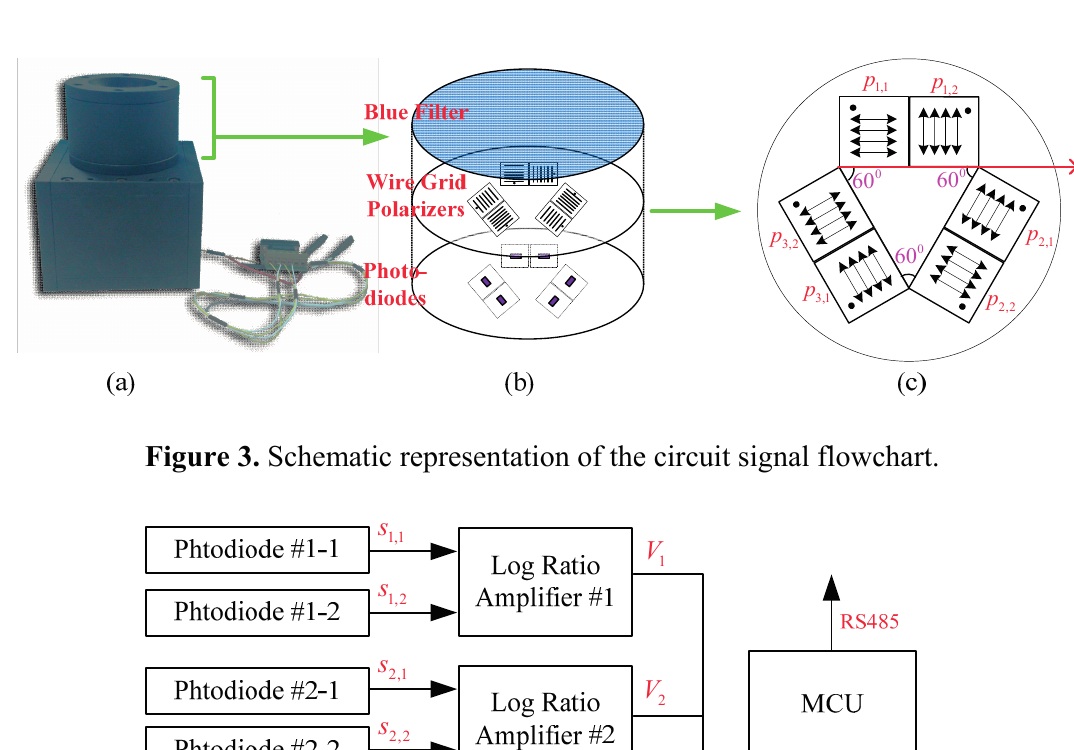
Figure 2. ( a ) The polarization sky-light navigation sensor, ( b ) mechanical structure, and ( c ) the ideal arrangement of three pairs of wire grid polarizers. The polarization direction p (the red arrow in (c)) is selected as sensor reference direction. of 1,1